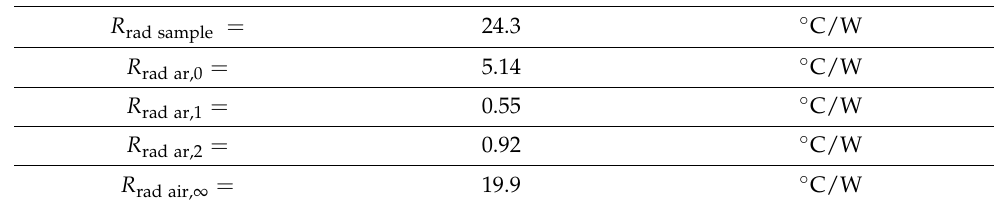
Table 4. Thermal resistances corresponding to radiative heat transfer. Subscripts ar and air denote the vertical cavities filled by argon or air, respectively; sample indicates the upper surface of the sample